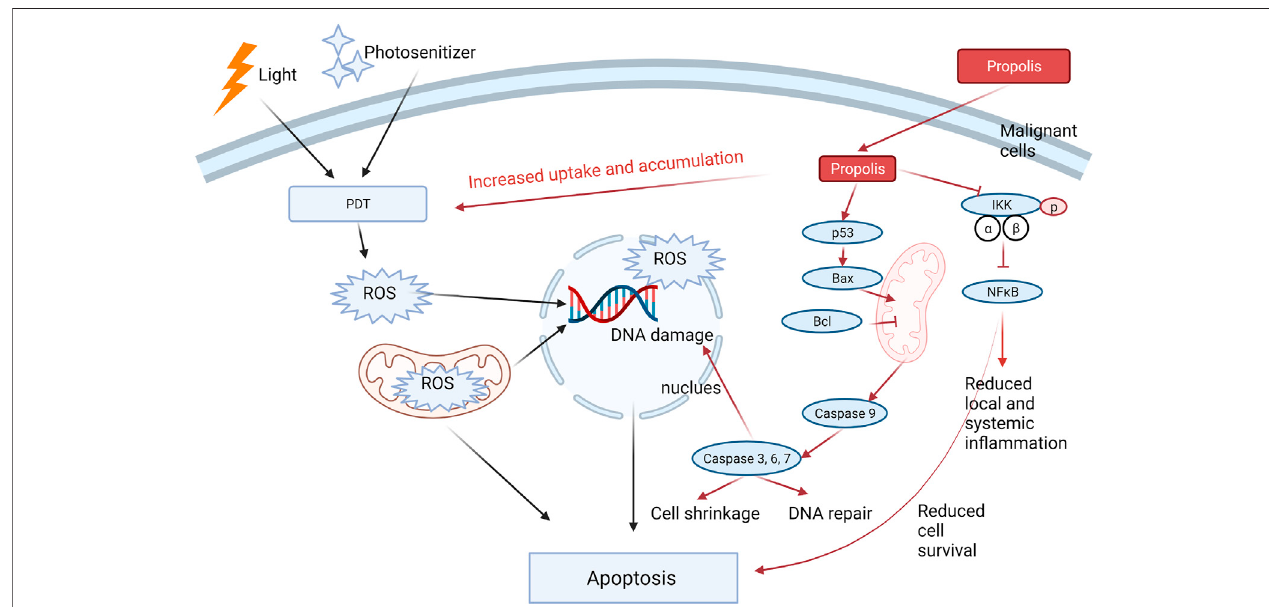
FIGURE 3 | Propolis increased the cytotoxic effect of PDT through three possible mechanistic actions: 1) increased the intracellular uptake and accumulation of PDT; 2) enhanced the apoptotic signaling by regulating the pro-apoptotic and apoptotic proteins; 3) Inhibited pIKK-NF κ B signaling, leading to reduced cell survival. In addition, propolis may reduce the local and systemic in fl ammation through the inhibition of the NF- κ B pathway. Red arrows represent the action of propolis in the combination, whereas black arrows represent the action of